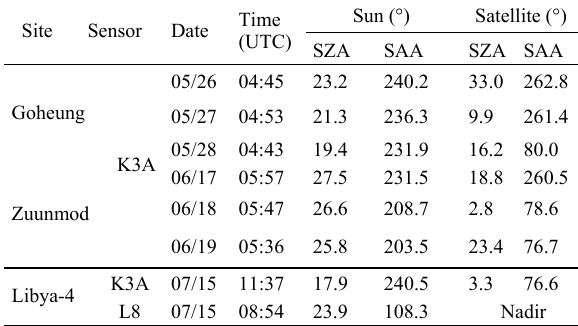
Table 1. Metadata of images in this